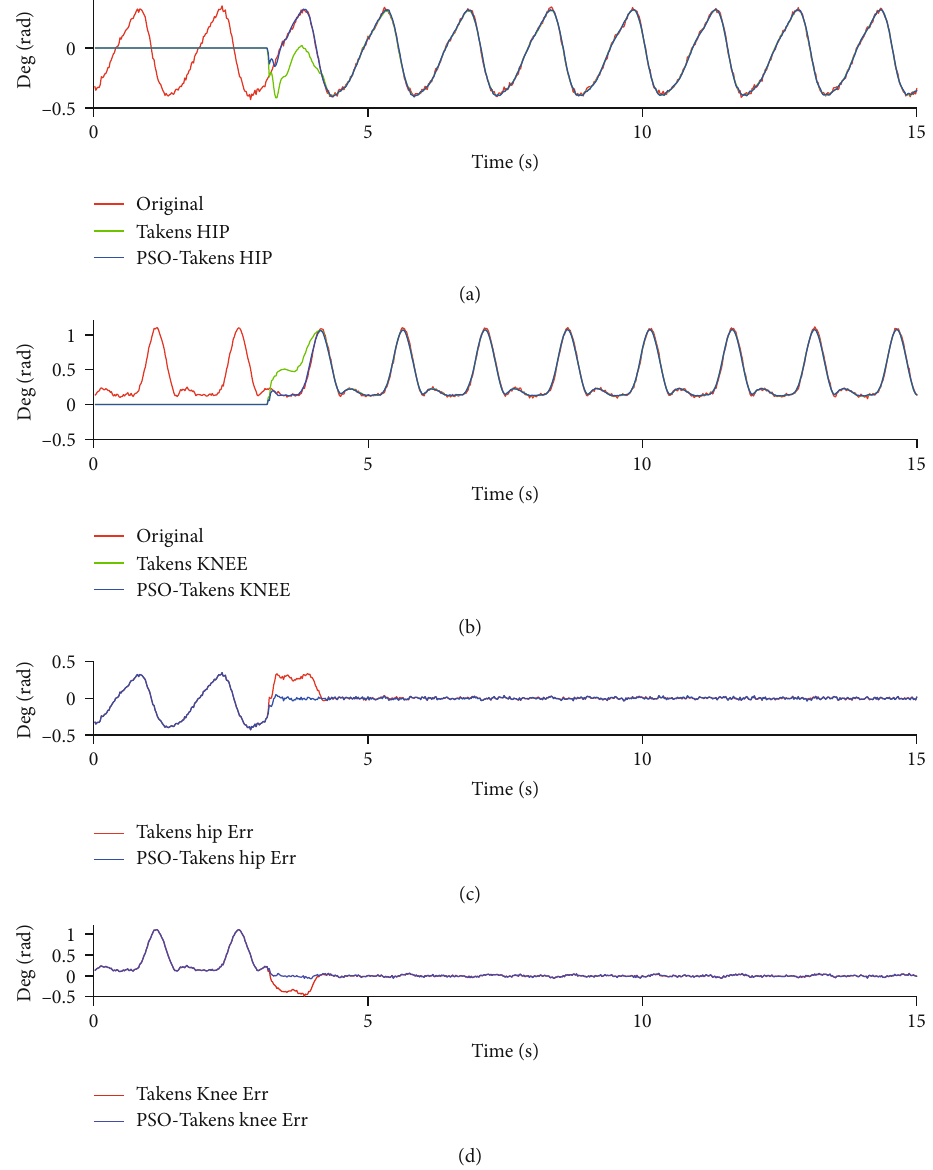
Figure 11: System joint angle output for standard gait data input (a). Hip joint angle output (b). Knee joint angle output (c). Hip joint follow control angle error (d). Knee joint follows control angle